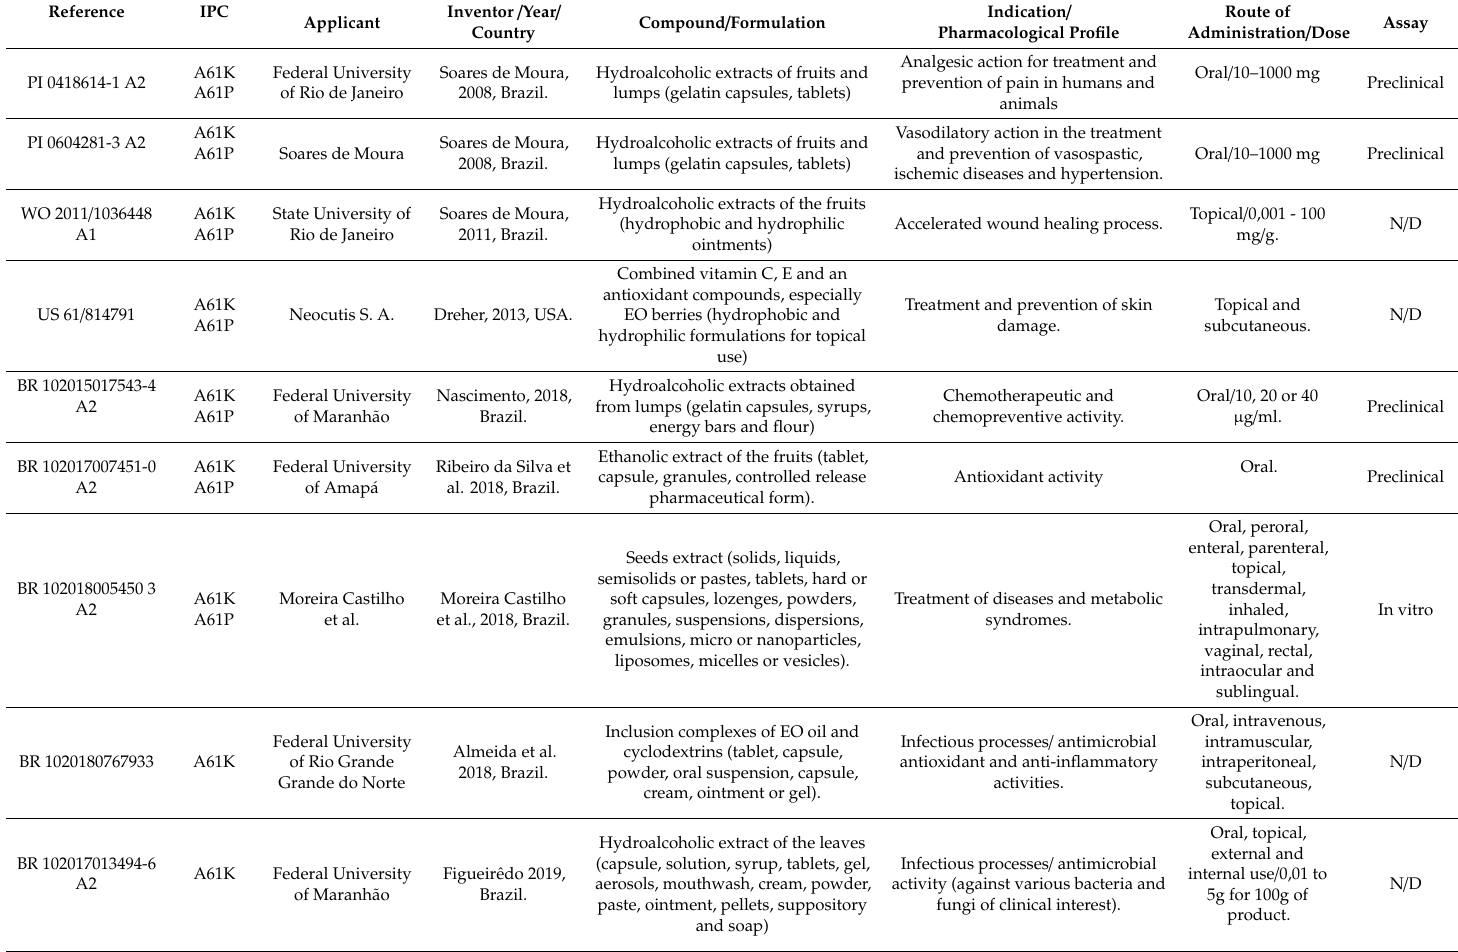
Table 4. Patents related to pharmaceutical formulations containing Euterpe oleracea Mart. for the treatment and prevention of general diseases.